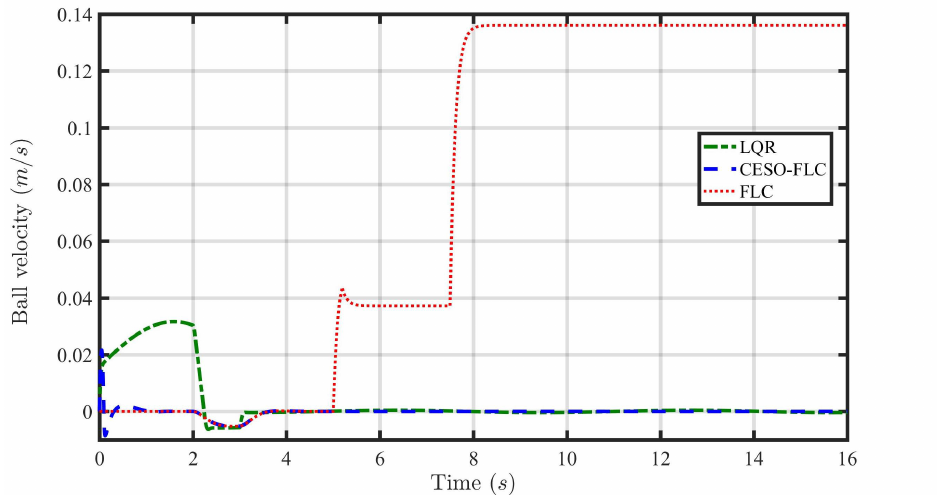
Figure 9. Response of steel ball velocity ( x 2 ) in the presence of parametric